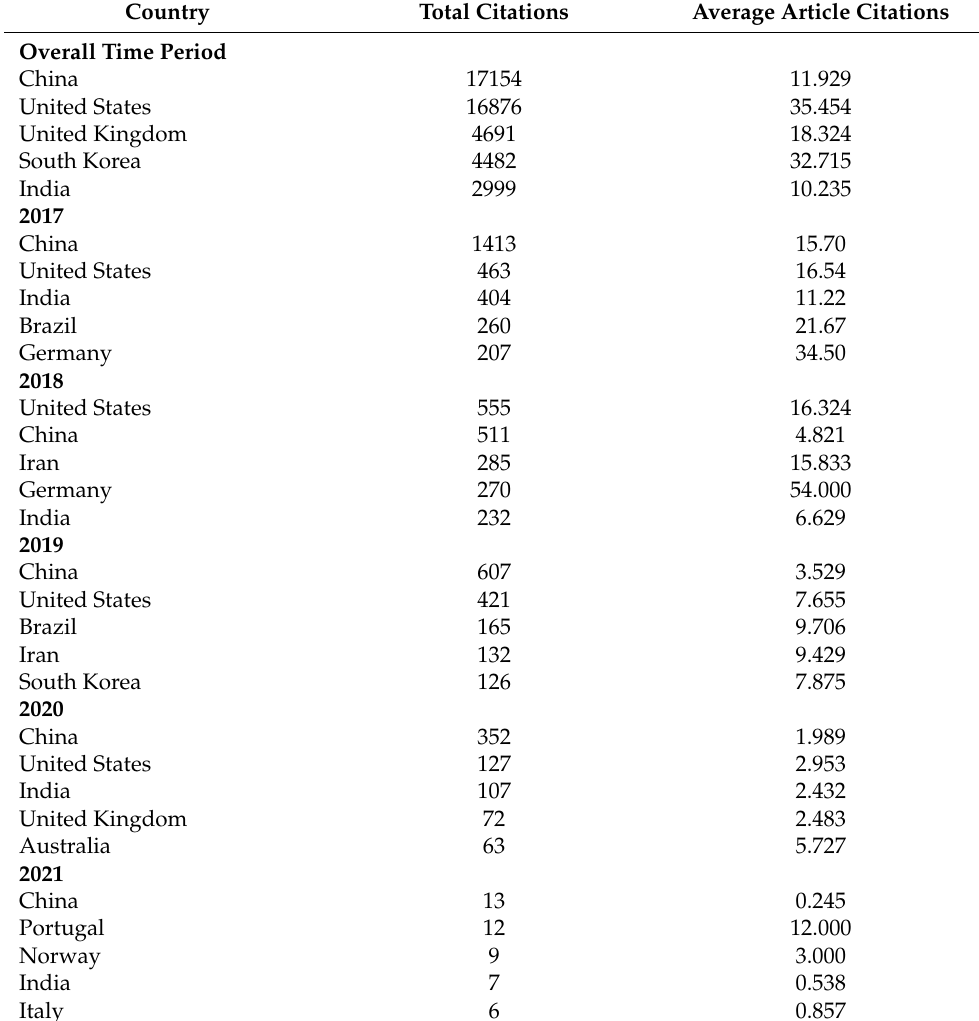
Table 9. Total citations per country, overall period, and per year.